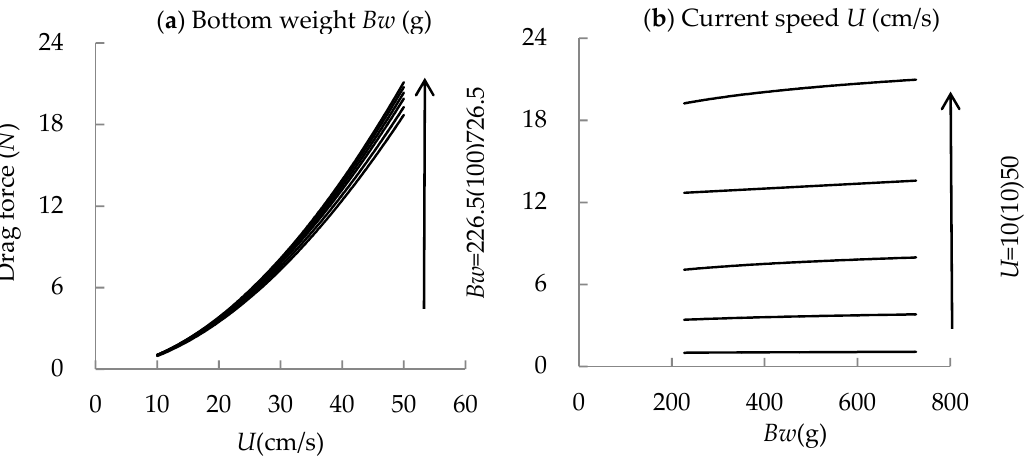
Figure 11. Relationship of drag force and bottom weight plotted against current speed. ( a ) the relationship of R D and U for each Bw ; ( b ) the relationship between R D and Bw for each U.